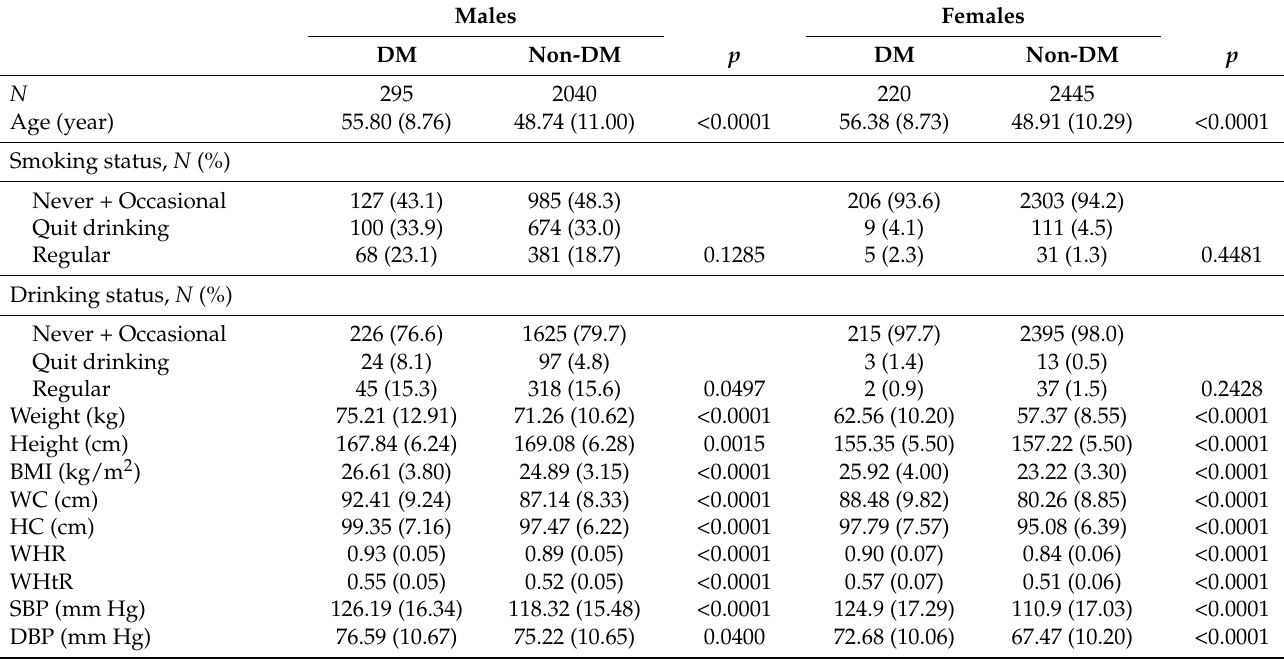
Table 1. Characteristics of the study population between males and females with and without diabetes mellitus (DM).